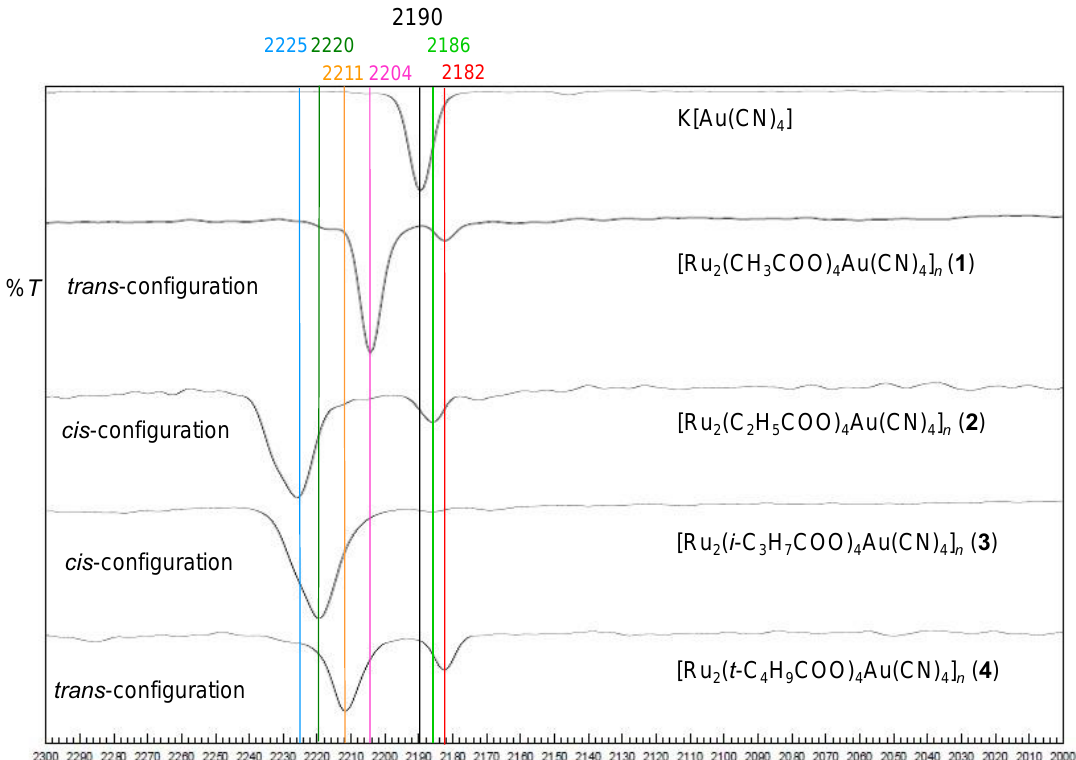
Figure 1. Infrared spectra of [Ru 2 (CH 3 COO) 4 Au(CN) 4 ] n ( 1 ), [Ru 2 (C 2 H 5 COO) 4 Au(CN) 4 ] n ( 2 ), [Ru 2 ( i - C 3 H 7 COO) 4 Au(CN) 4 ] n ( 3 ), and [Ru 2 ( t -C 4 H 9 COO) 4 Au(CN) 4 ] n ( 4 ) in the 2300–2000 cm − 1 region.